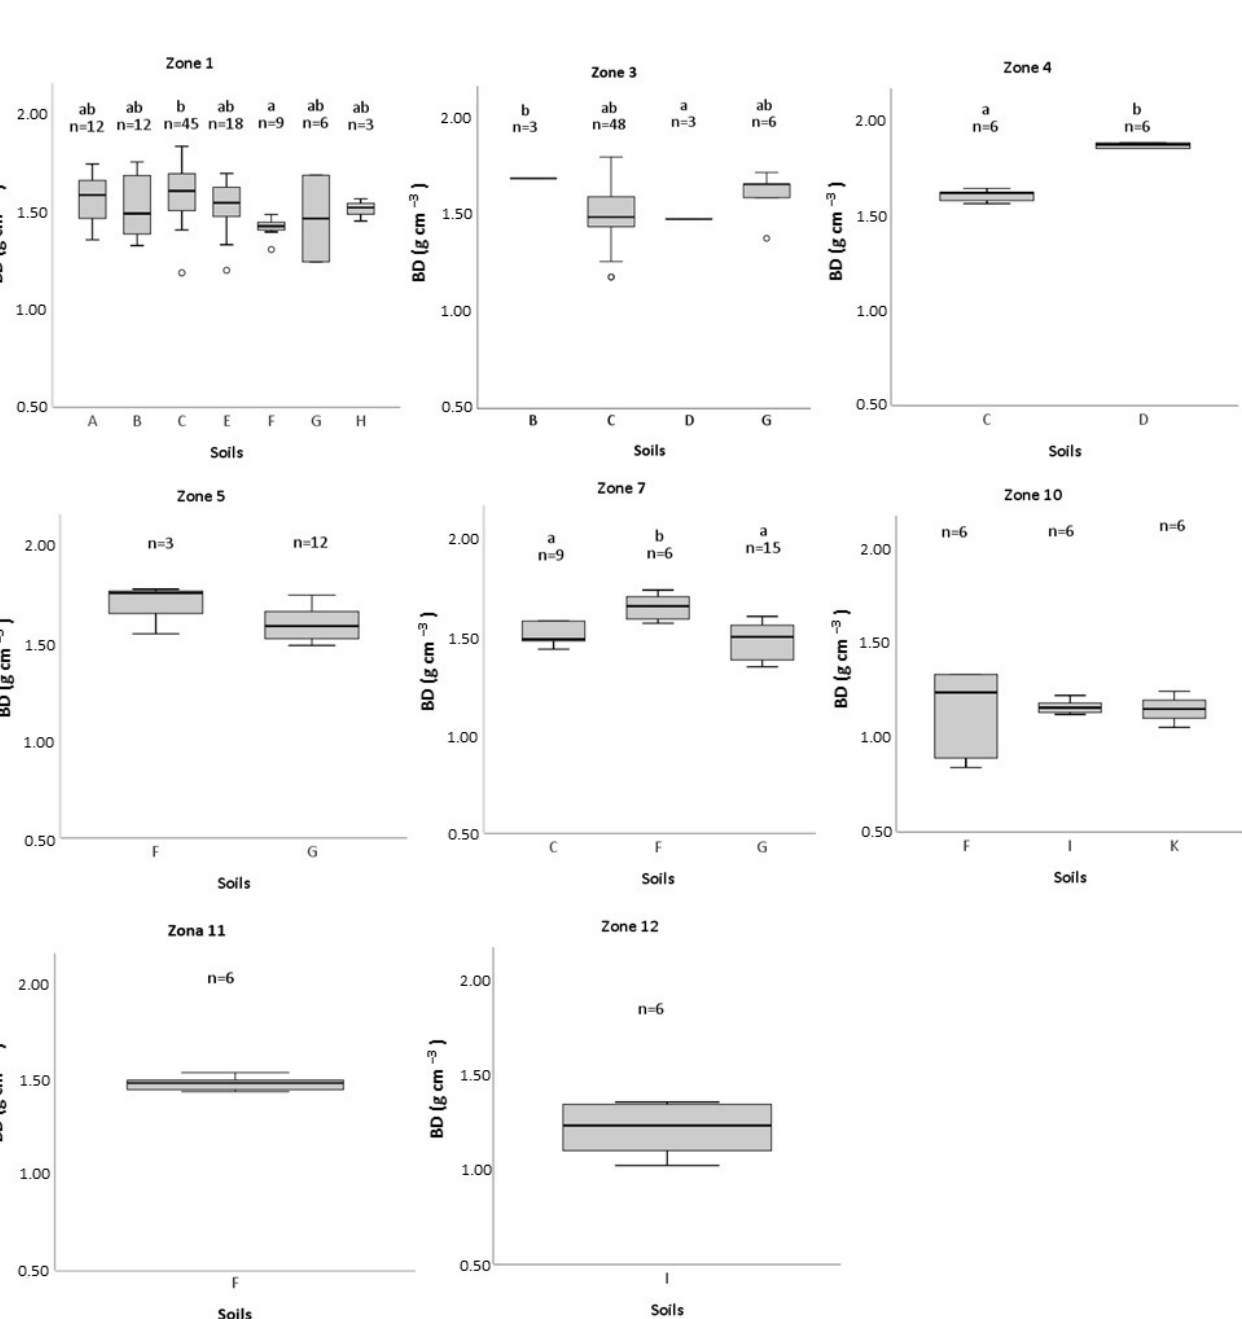
Figure 3. Bulk density (BD) in conventionally managed topsoils (0–30 cm) for the different types of soils in each zone selected for this study. Center lines show the medians, box limits indicate the 25th and 75th percentiles, whiskers extend 1.5 times the interquartile range from the 25th and 75th percentiles, outliers are represented by dots. Values showing the same letter belong to the same homogeneous group according to Duncan’s test ( p < 0.05). A: Xerolls, B: Ustolls, C: